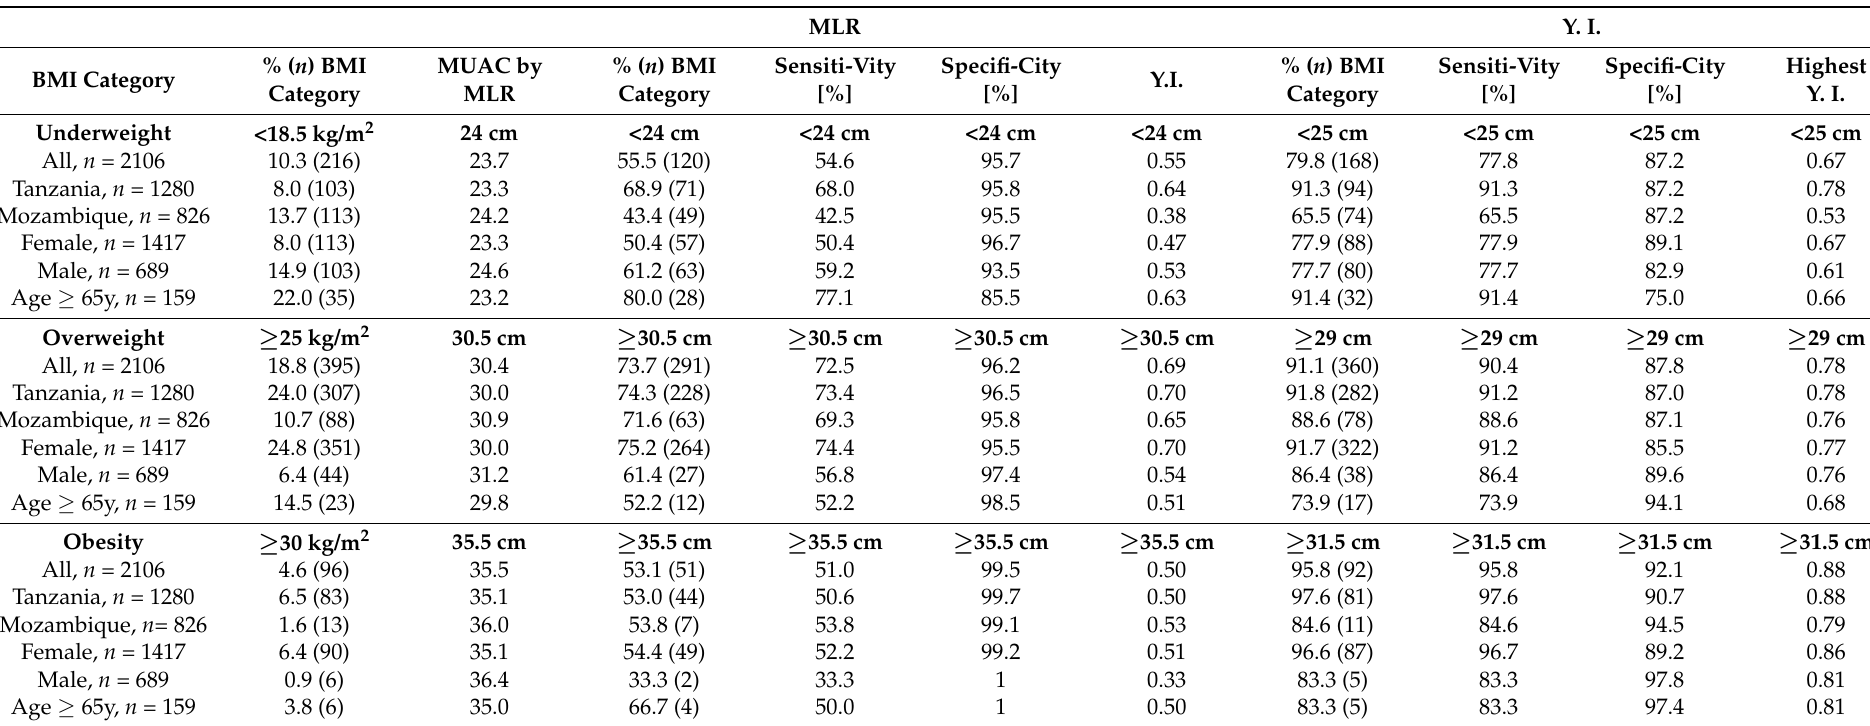
Table 4. Identification of farmers with underweight, overweight, and obesity by MUAC cut-offs calculated with multiple linear regression vs. those selected by highest Youden’s Index.